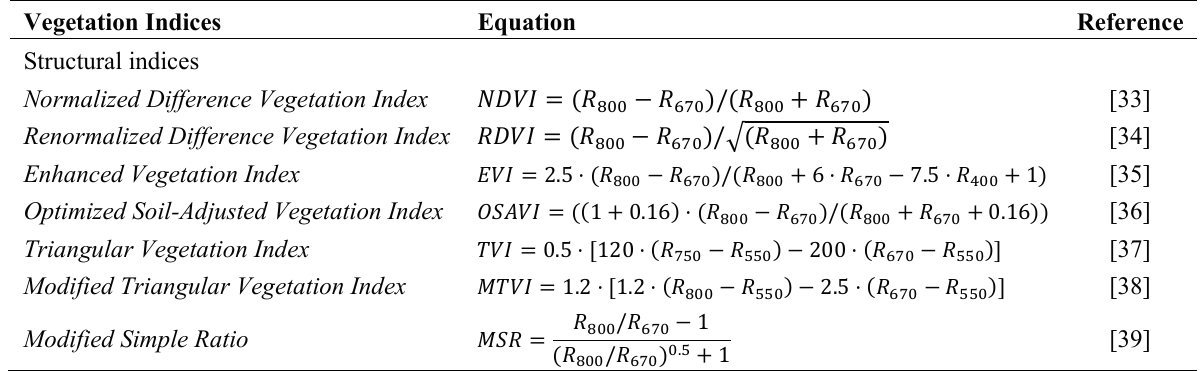
Table 2. Overview of the vegetation indices that contribute most to the model conducted in this study and their